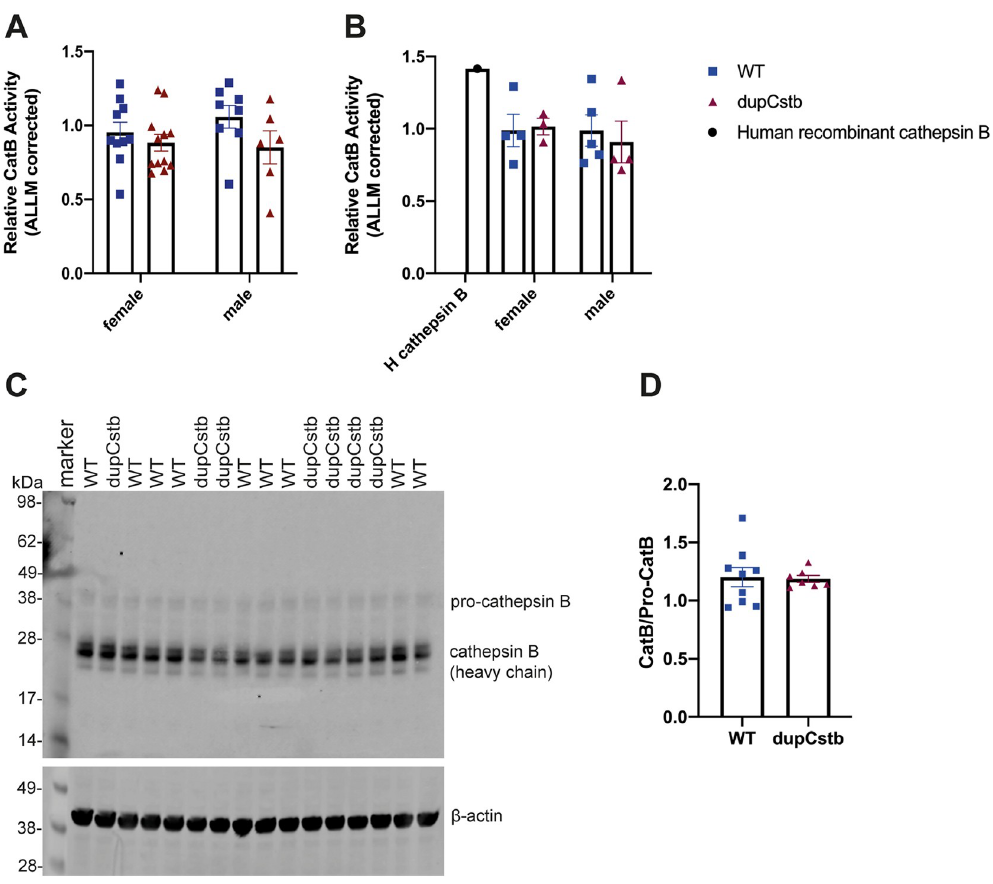
Fig 4. Activity of cathepsin B in cortical lysates of 3- and 6- month-old mice. Total cortical proteins were used to determine enzyme activity, as the gain in fluorescence during the linear portion of the reaction curve relative to the wildtype mean. (A) Cortical relative cathepsin B activity at 3-months of age, graphed as group means ± SEM (n = 18 per genotype; (22 females and 14 males in total), revealed no statistically significant effects of dupCstb or sex (univariate ANOVA). (B) Cortical relative cathepsin B activity at 6-months of age, graphed as group means ± SEM, (dupCstb n = 7, wildtype n = 9; 7 females and 9 males in total), revealed no statistically significant effects of dupCstb or sex (univariate ANOVA). Recombinant human cathepsin B (R&D Systems, Cat. No. 953-CY-010) was used as a positive control. (C) Representative western blot probed with an anti-cathepsin B antibody that recognises pro-cathepsin B and cathepsin B heavy chain and an anti- β -actin antibody. (D) Protein band densities of pro-cathepsin B and cathepsin B heavy chain were quantified using ImageJ, normalised to β -actin, and are shown as cathepsin B/pro-cathepsin B ratio in the dupCstb group relative to the ratio in wildtype, graphed as group mean ± SEM (dupCstb n = 7, wildtype n = 9; 7 females and 9 males in total).